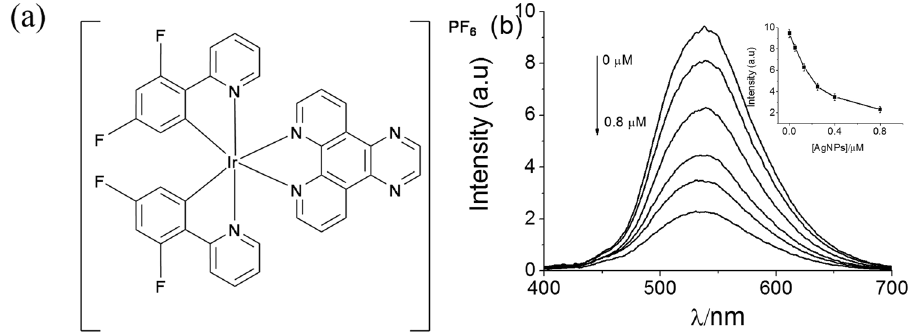
Figure 1. ( a ) Chemical structure of Ir(III) complex 1 . ( b ) Luminescence emission spectra 1.0 μ M complex 1 in Tris-HNO 3 buffer solution (pH 7.0) containing different concentrations of Ag nanoparticles. The inset is the luminescence intensity plotted against the Ag nanoparticles concentration (from top to bottom: 0, 0.05, 0.13, 0.25, 0.4, and 0.8 μ M).